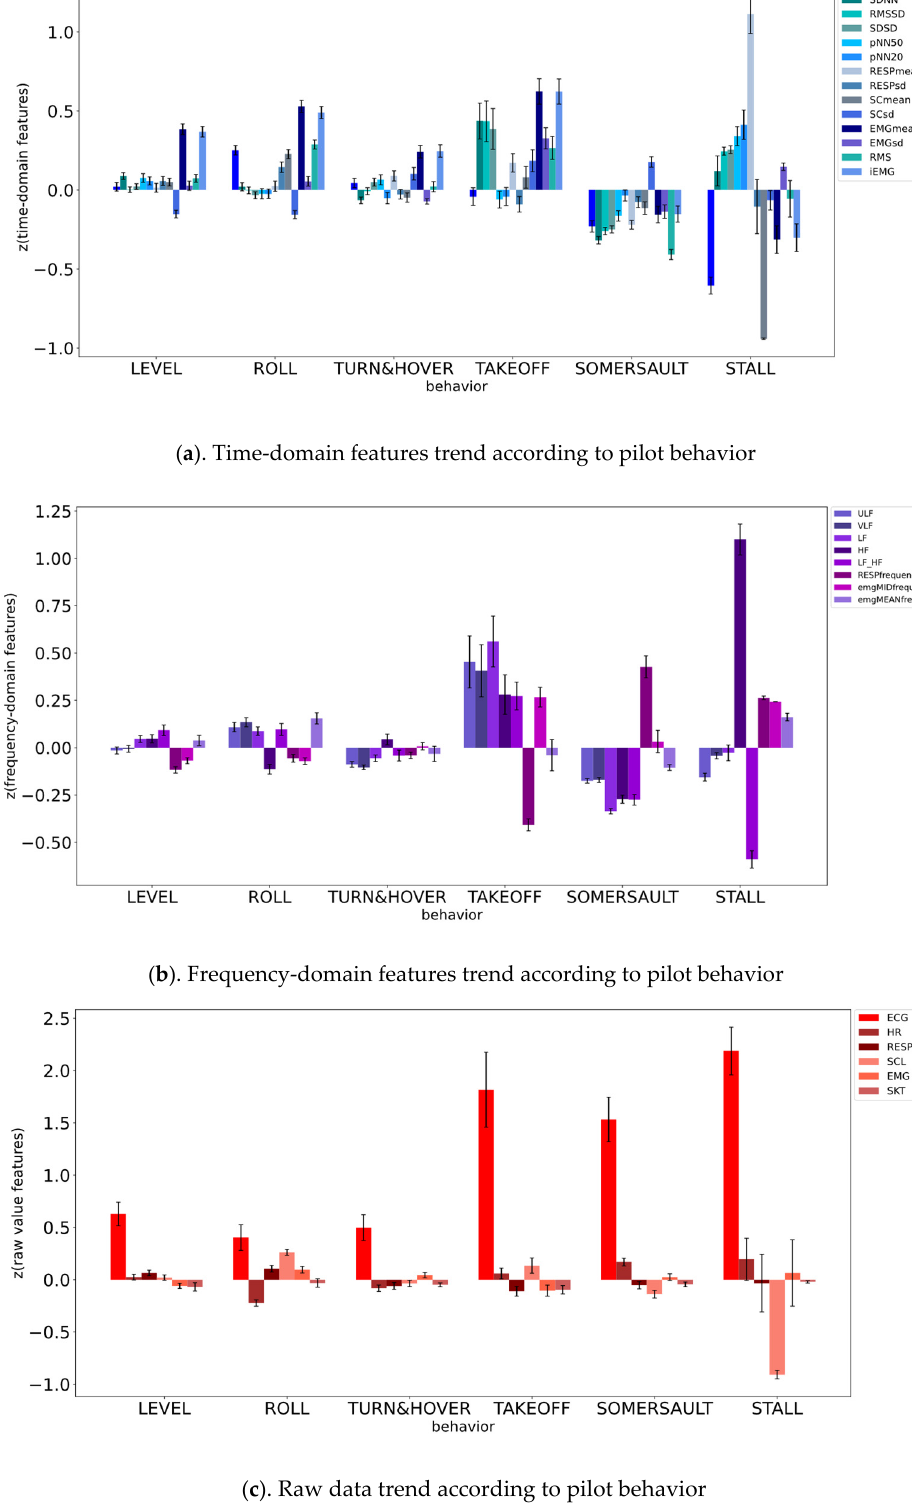
Figure 5. Data trend according to pilot behavior. To objectively analyze the relationship between these physiological parameters and different behaviors, we analyzed them using the Kendall correlation analysis [53], as shown in Figure 6. It turned out that the ECG value, HR, SDNN, SDSD, pNN50, pNN20, VLF, LF, HF, RESP value, REAP mean, RESP standard deviation, SC standard deviation, EMG value, RMS, iEMG, EMG mid frequency, EMG mean frequency, and SKT value had no evident correlations with behavior; LF/HF, SCL, the EMG mean, and EMG standard deviation had moderate correlations with behavior; and NN, ULF, RESP frequency, SCL, and the SCL mean had high correlations with behavior. Parameters with a dark-green background were negatively correlated with the degree of difficulty, and parameters with a light-green background were positively correlated with the degree of difficulty. The trends in physiological parameters were consistent with previous studies [54–58]. Never- theless, the results showed slight differences in ULF compared to some studies [9,59–62] which believed that ULF cannot reflect a human’s workload level. After further literature research and analysis, our results were found to be justified. The pilot is in a complex state when performing flight maneuvers, inducing complicated physiological responses asso- ciated with cognition, fatigue, stress, concentration, or distraction, etc. So, studies which only take workload into consideration are neither comprehensive nor convincing with regard to difficulty rating. As a result, despite ULF being unable to reflect a human’s workload level, it could possibly be used in difficulty level recognition.